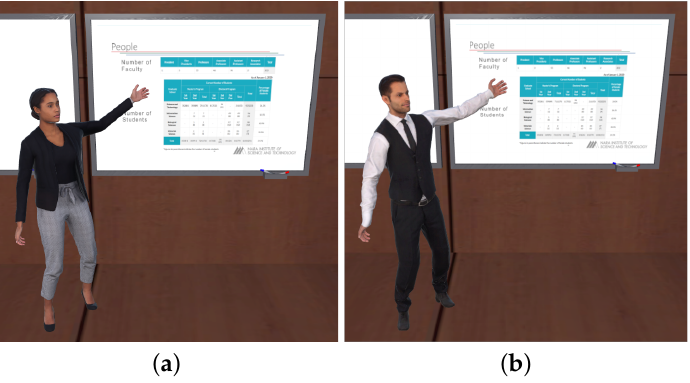
Figure 5. Two types of avatars with different genders. ( a ) Female avatar. ( b ) Male